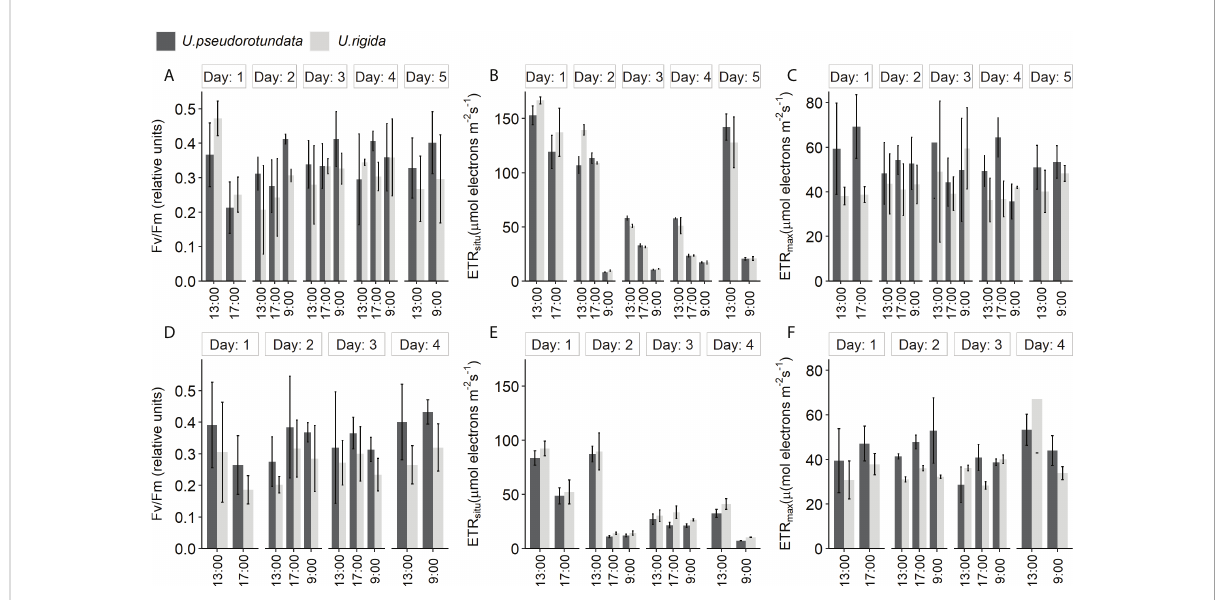
FIGURE 6 Diurnal changes of photosynthetic parameters: maximum quantum yield ( F v / F m ), in situ electron transport rate (ETR situ ), and maximum electron transport rate (ETR max ) of U. pseudorotundata and U. rigida in two conditions: 50% fi sh ef fl uent (5 days): (A – C) ; 100% fi sh ef fl uent (4 days): (D – F) . Values are mean ± SD, n =